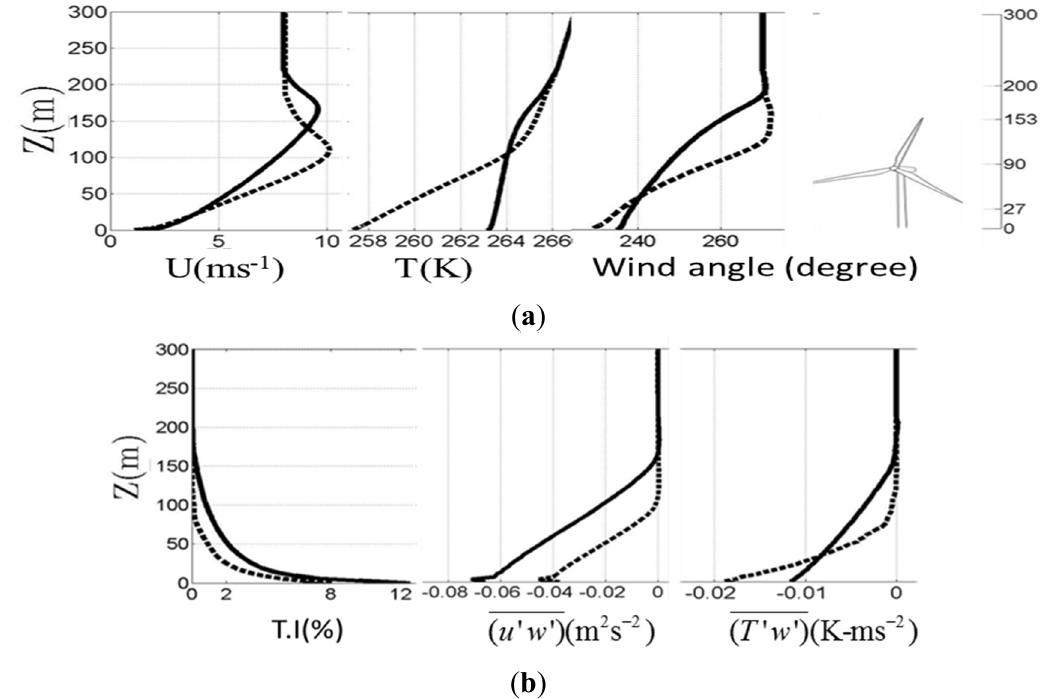
Figure 1. ABL metrics that are of significant to WT wake dynamics: ( a ) mean streamwise velocity, mean temperature and wind angle (degrees); ( b ) turbulence intensity (T.I.), shear stress and buoyancy flux. Solid line represents the low-stable ABL regime and the dashed line represents the moderately-stable ABL